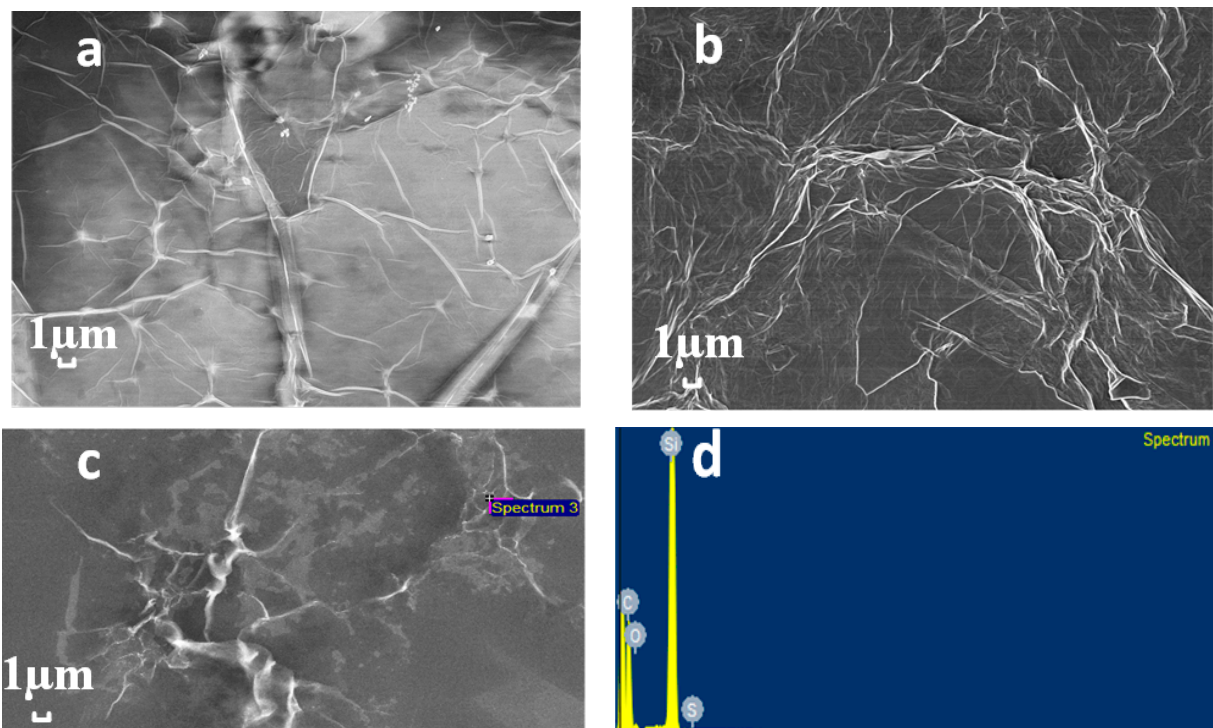
Figure 3. SEM images of ( a ) GO and ( b ) S-GO. ( c ) EDS spectrum and ( d ) element content of S-GO . Table 1. Element content of S-GO.